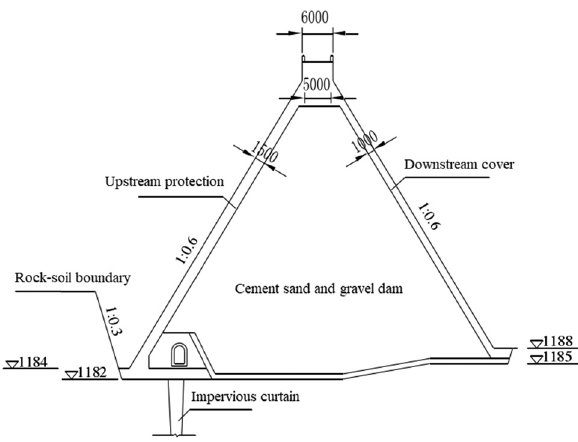
Figure 1: Operation section of Shoukoubao